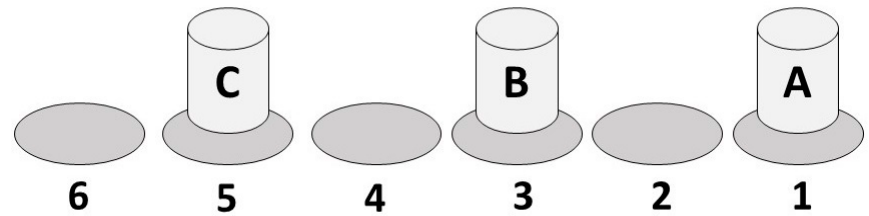
Figure 1. Initial arrangement of the cans and target circles for the soda pop tests, both hand and foot.